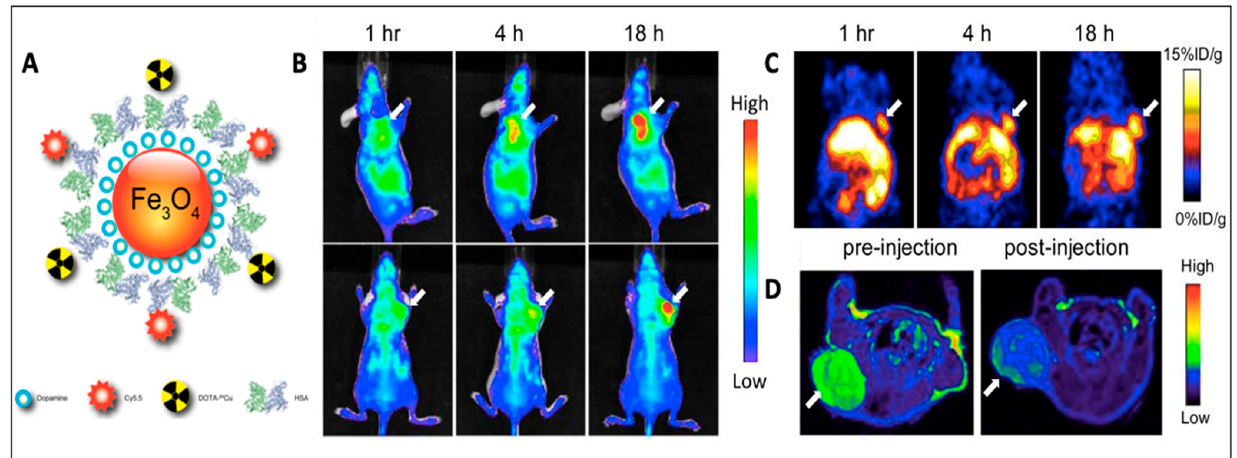
Figure 7. ( A ) Triple-functional 64 Cu-DOTA and Cy5.5-labeled iron oxide nanoparticles. ( B ) NIRF (near-infrared fluorescence) in vivo images. ( C ) In vivo PET (positron emission tomography) images. ( D ) MRI images pre-and post-injection (after 18 h). Reproduced with permission from Ref. [124]. Copyright 2010 Elsevier.